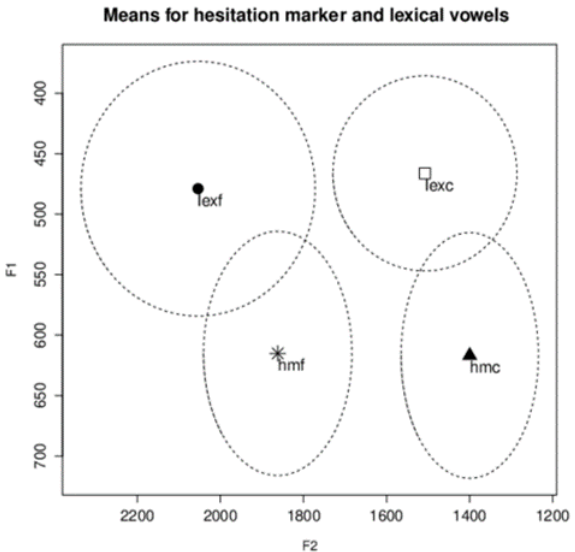
Figure 9. Means for front and central quality vowels, for both lexical and hesitation marker vowels (‘lexf’ = front lexical vowels; ‘lexc’ = central/back lexical vowels; ‘hmf’ = HM front vowels; ‘hmc’ = HM central/back vowels)